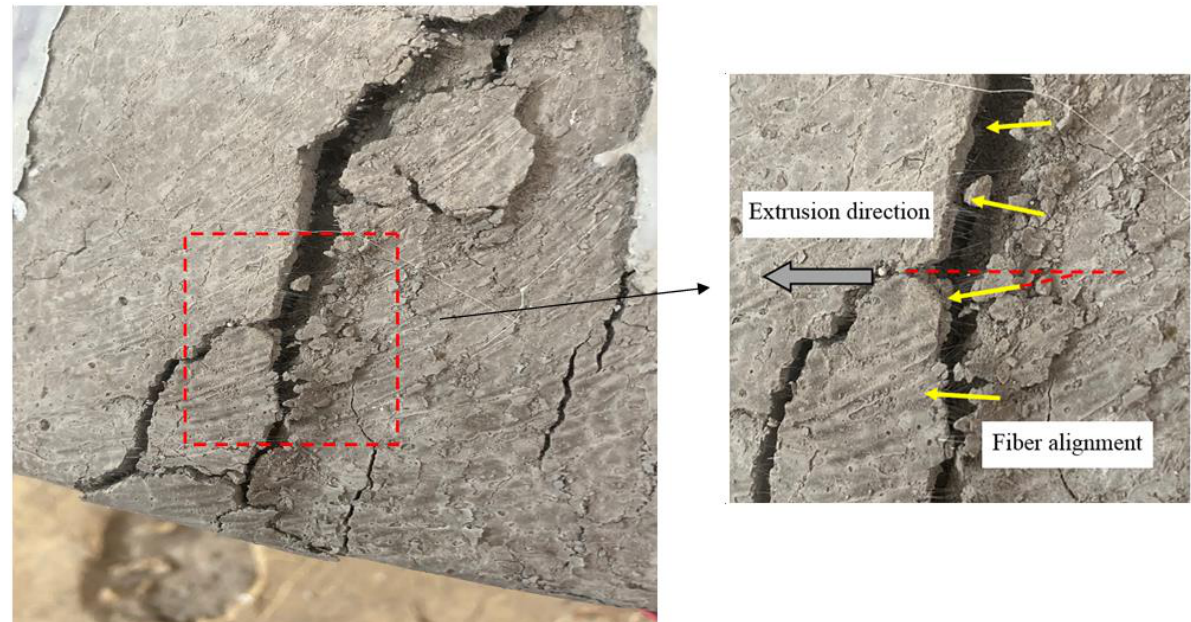
Figure 12. Fiber distribution of fracture surface.